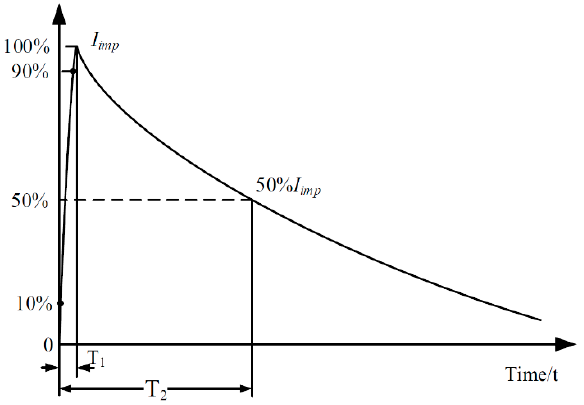
Figure 19. The schematic diagram of pulse current waveform.